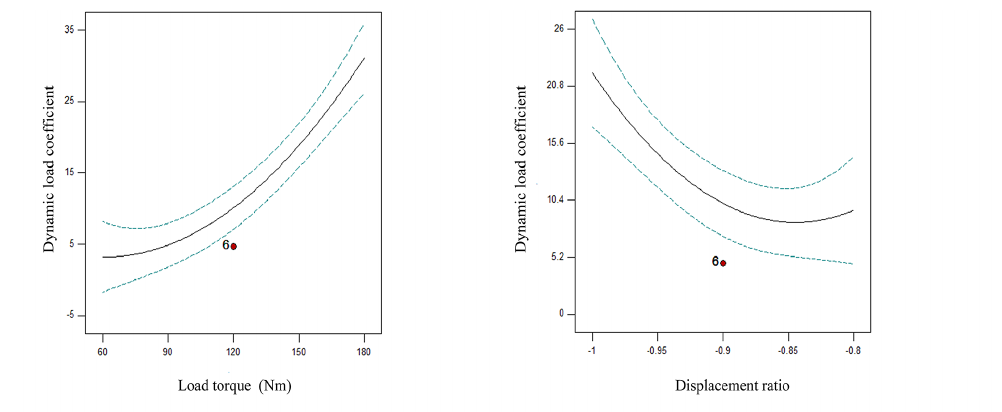
Figure 5. Single influencing factor analysis of dynamic load coefficient.